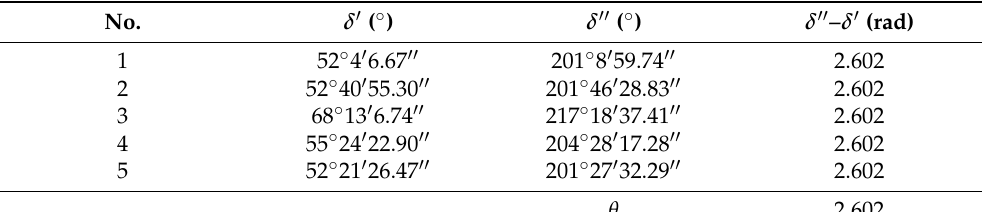
Table 4. Direction and rotation angles of measurement points.